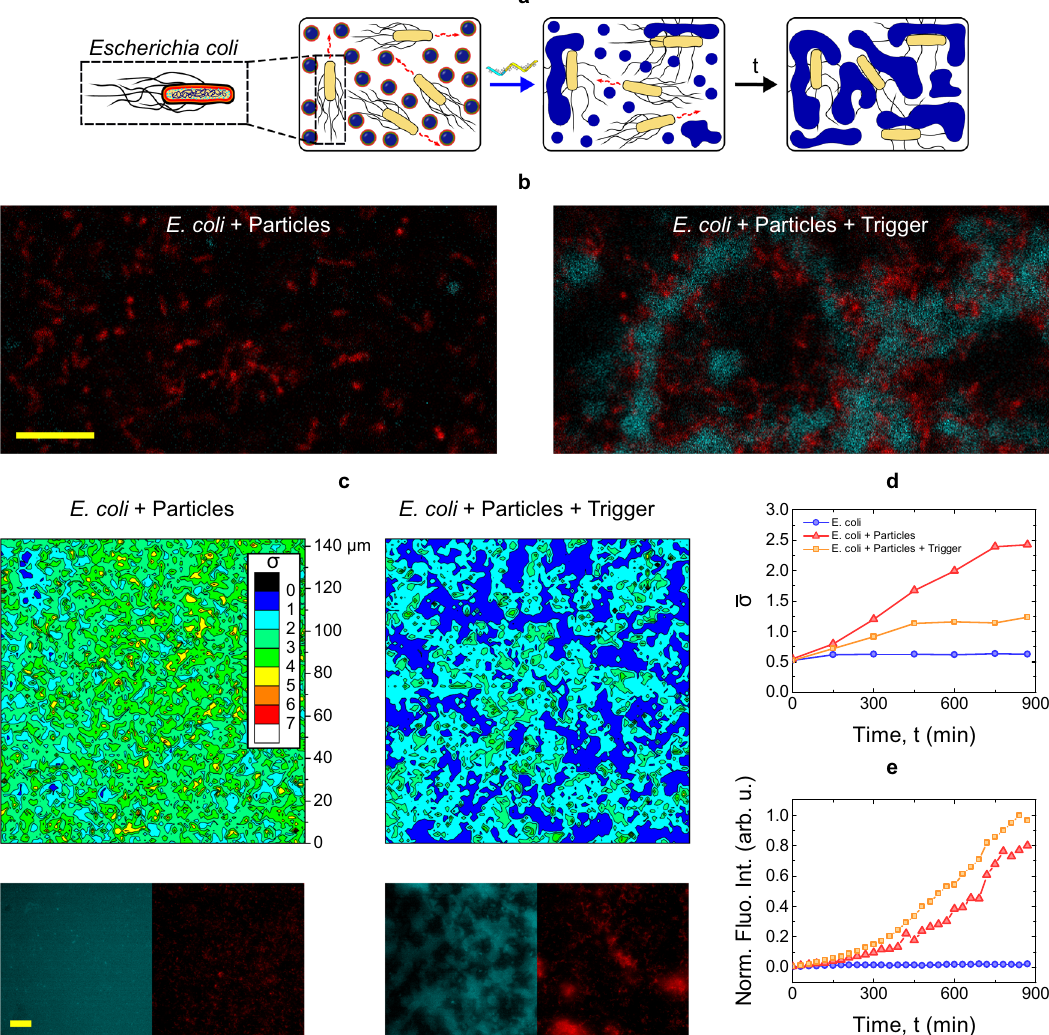
Fig. 5 E. coli can be trapped by DNA networks formed by unprotected particles. a Schematic representation of trigger-induced E. coli entrapment. Once activated by the addition of the trigger strand, particles assemble into a sticky DNA network. Swimming E. coli stick to, or become embedded in the aggregates, which renders them immobile. b Confocal micrographs demonstrating E. coli entrapment. Core C-stars ( fl uorescein) are shown in cyan, E. coli (mKate2) in red. Scale bar 10 μ m. c Top: trigger-induced E. coli entrapment as quanti fi ed through a motility parameter σ (extracted from microscopy videos, see Methods and main text for de fi nition) for samples with and without the addition of trigger. The smaller and non-uniform σ -values detected in the presence of the trigger con fi rm the ability of the DNA aggregates to hinder E. coli motion. See Supplementary Fig. 16 for the σ -maps extracted at different incubation stages, where the absence of signi fi cant signal from the early-time maps con fi rms that Brownian motion from the particles has a comparatively negligible effect on σ . Bottom: epi fl uorescence micrographs in the DNA (cyan) and E. coli (red) channels collected in the corresponding fi elds of view. Scale bar 20 μ m. d Time-trace of the frame averaged motility parameter (cid:1) σ for samples of E. coli and DNA particles (with and without trigger) and a control sample in which no DNA particles were present. The increase in (cid:1) σ observed in the presence of particles can be ascribed to bacterial growth, as con fi rmed in panel e and Supplementary Fig. 17. While (cid:1) σ continues to grow steadily in the sample with non-triggered particles, as more moving bacteria are generated, DNA-aggregation and E. coli entrapment cause the curve to plateau. e Normalized fl uorescence intensity of E. coli -expressed mKate2 protein as extracted from epi fl uorescence images for the samples in panel ( d ). An increasing signal indicates bacterial growth, which occurs in the presence of DNA particles but is absent for the control DNA-only sample, suggesting that E. coli can use the DNA particles as a food source (see also Supplementary Fig. 17). Data shown in panels ( b – e ) was acquired in two independent